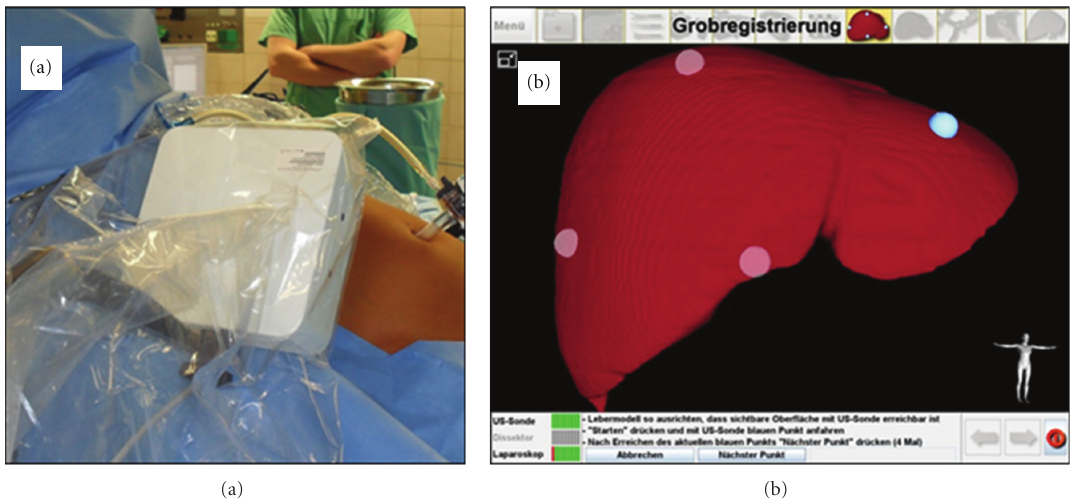
Figure 6: Intraoperative liver registration. (a) Positioning of the field generator beside the patient, (b) liver registration using four defined spots. The landmark on the left lobe is already activated.